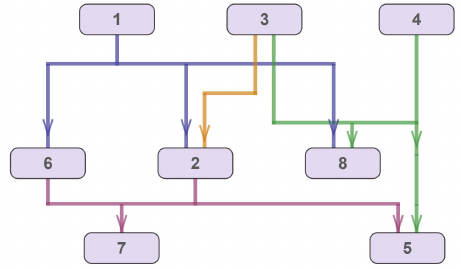
Figure 12. An example of layout of a hypergraph obtained with the mathematical